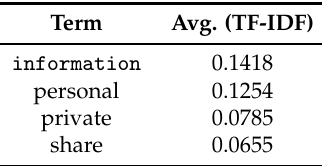
Table 2. The weight for each term is computed by averaging the Term Frequency and the Inverse Document Frequency (TF-IDF) scores over all